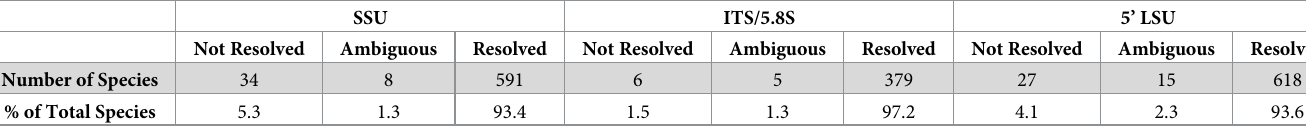
Table 3. Summary of the results regarding how well the various rDNA regions resolved species